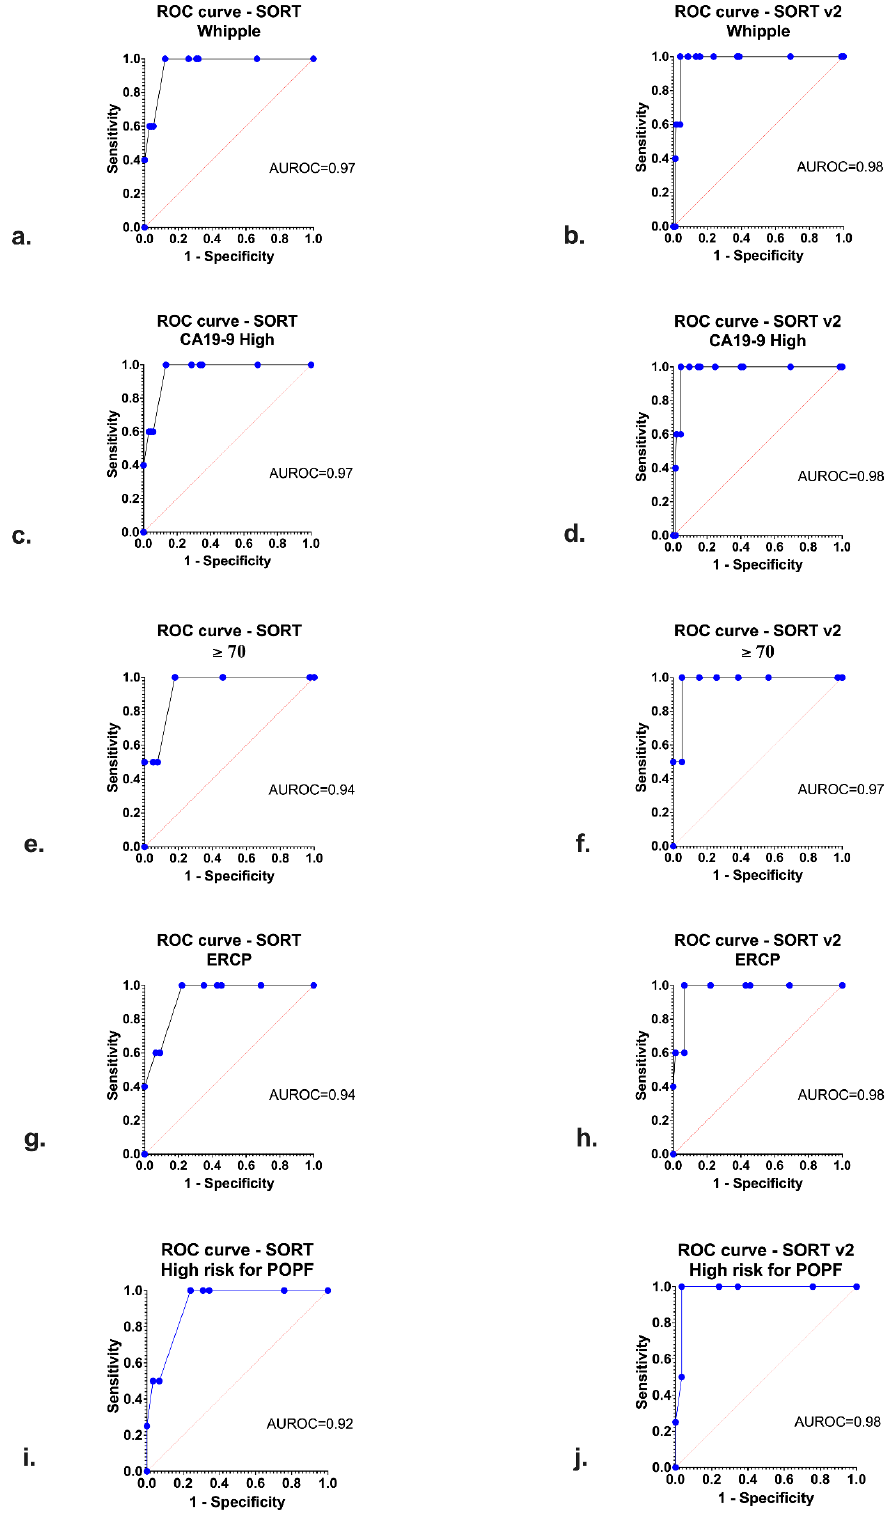
Figure 3. Receiver Operating Characteristic (ROC) curves regarding the discrimination of Surgical Outcome Risk Tool (SORT) and SORT v2 in the following subgroups: ( a , b ): pancreaticoduodenec- tomy procedure; ( c , d ): CA19-9 ≥ 500; ( e , f ): age ≥ 70; ( g , h ): pre-operative endoscopic retrograde cholangiopancreatography (ERCP); ( i , j ): High risk for postoperative pancreatic fistula